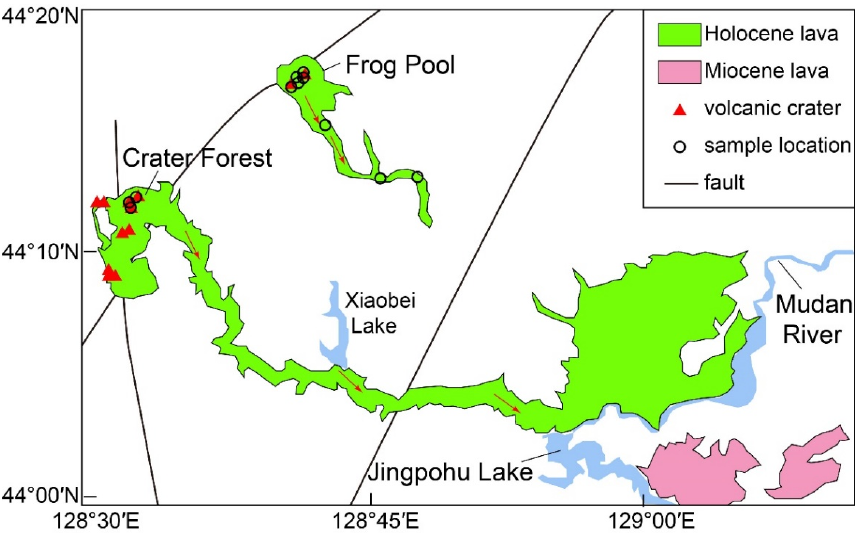
Figure 2. Distribution of Holocene lavas and craters within the Jingpohu volcanic field.